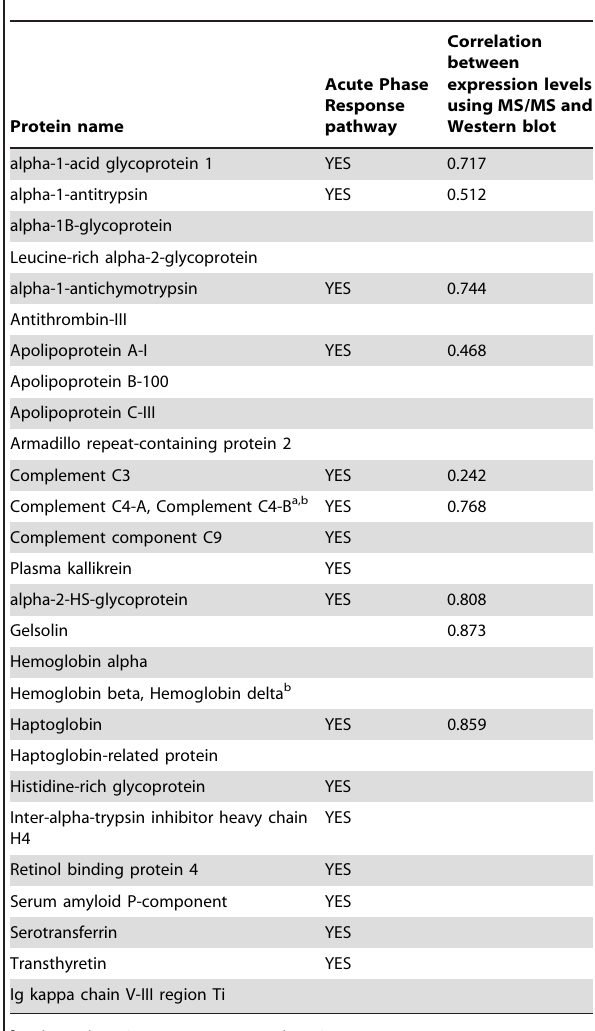
Table 2. List of 29 proteins representing 27 protein identifications from the 41 selected peaks, with pathway assignments according to ingenuity analysis and the validation of ms/ms results using western blots on 12 subjects (6 ILD cases and 6 controls).